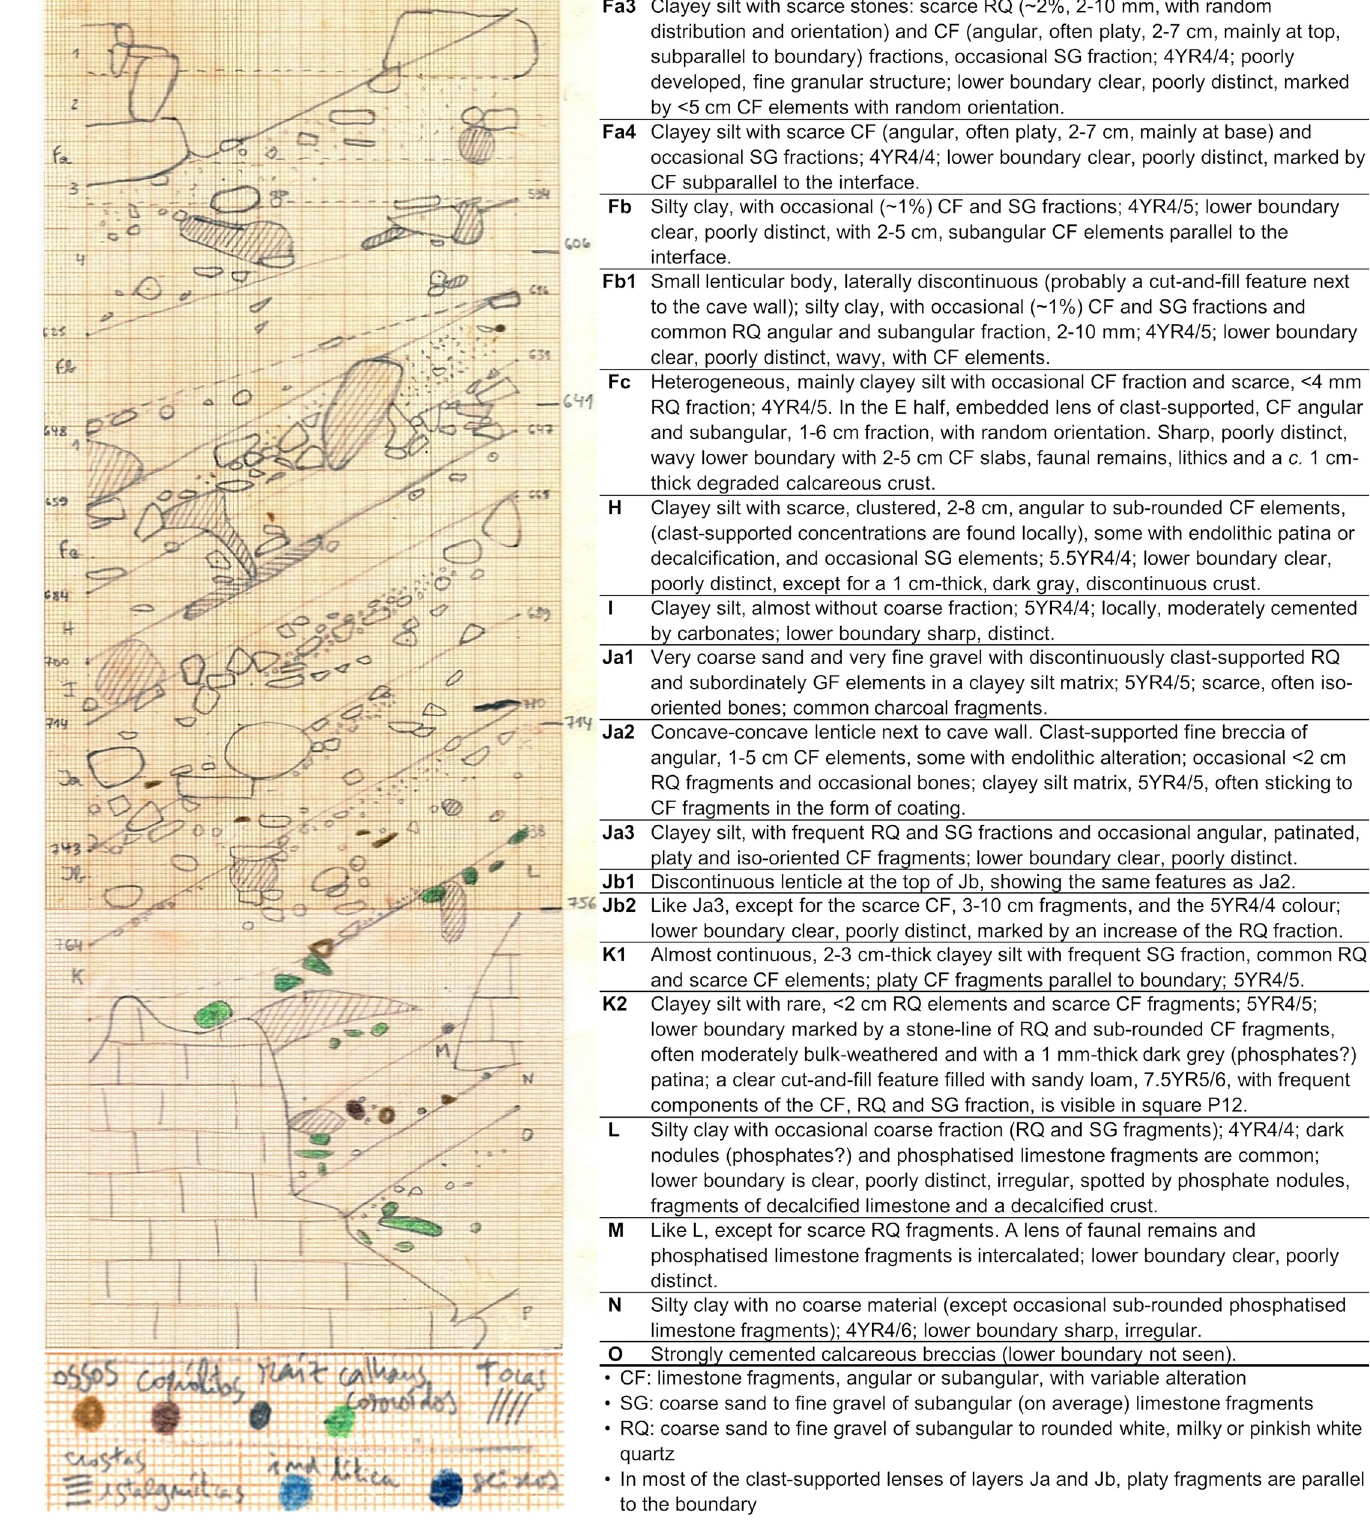
Fig 5. The Pleistocene succession. Illustration (original field record, hand-drawn at 1:10; elevations in cm below datum) and geological description of the P > O11 (North) profile of square P11 extant at the end of the 1979–88 excavations (completed with observations made in P11 > 10 and P > Q11-13). https://doi.org/10.1371/journal.pone.0259089.g005 PLOS ONE | https://doi.org/10.1371/journal.pone.0259089 October 27,